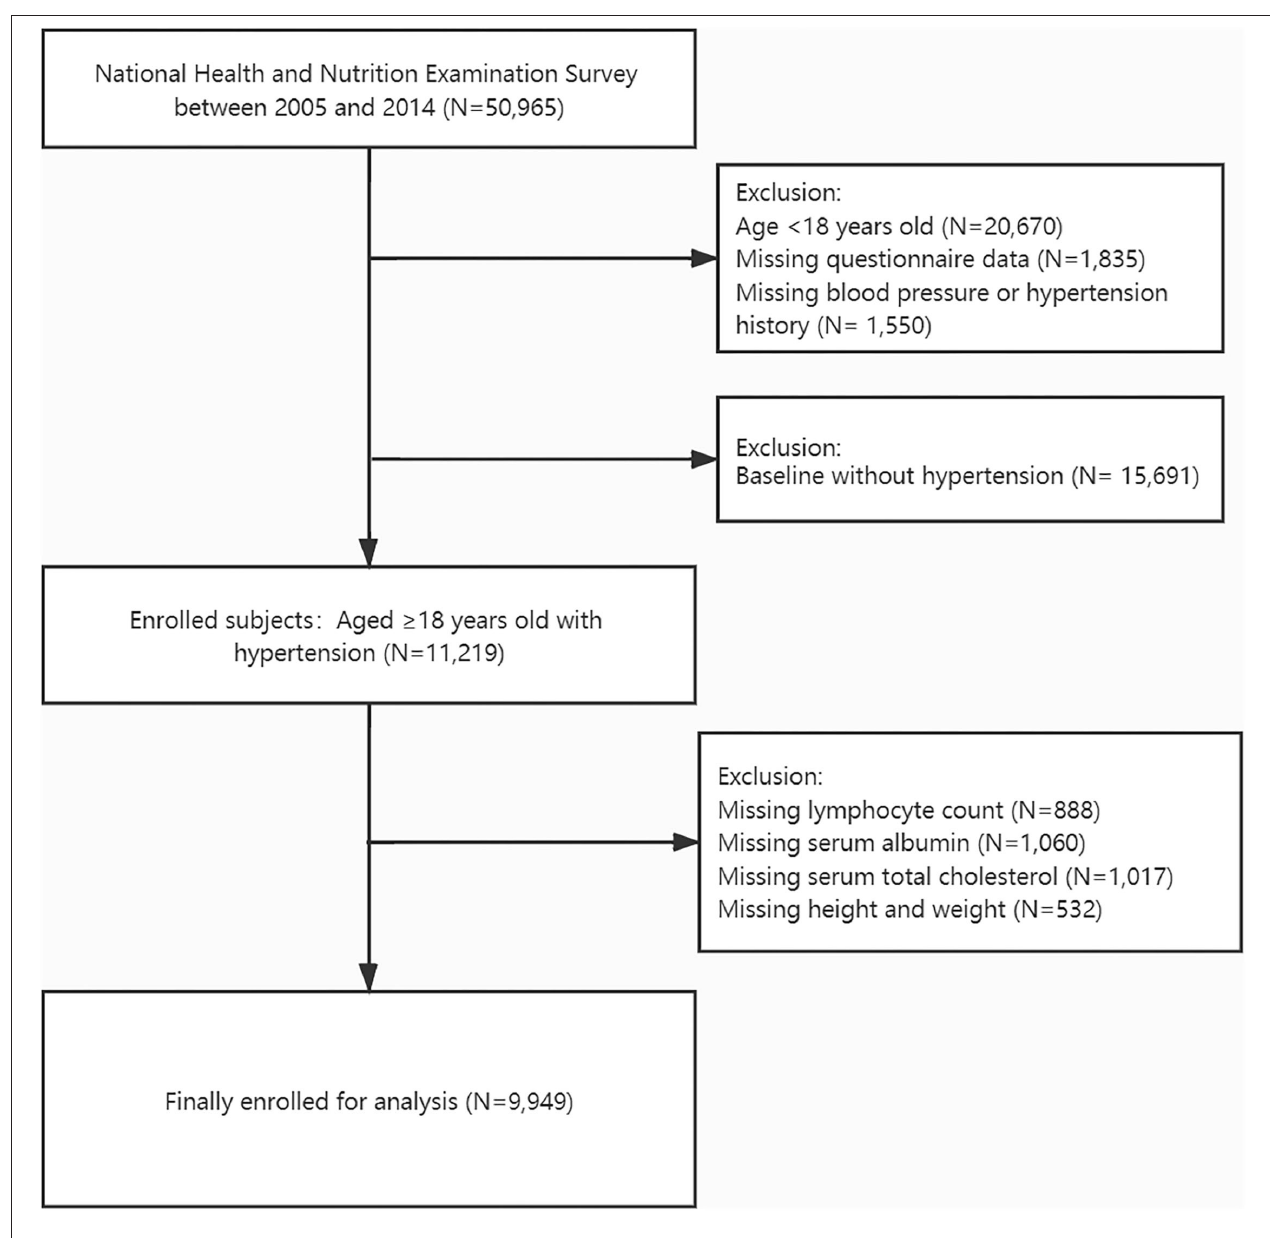
FIGURE 1 | Flow diagram for the selection of the study population.